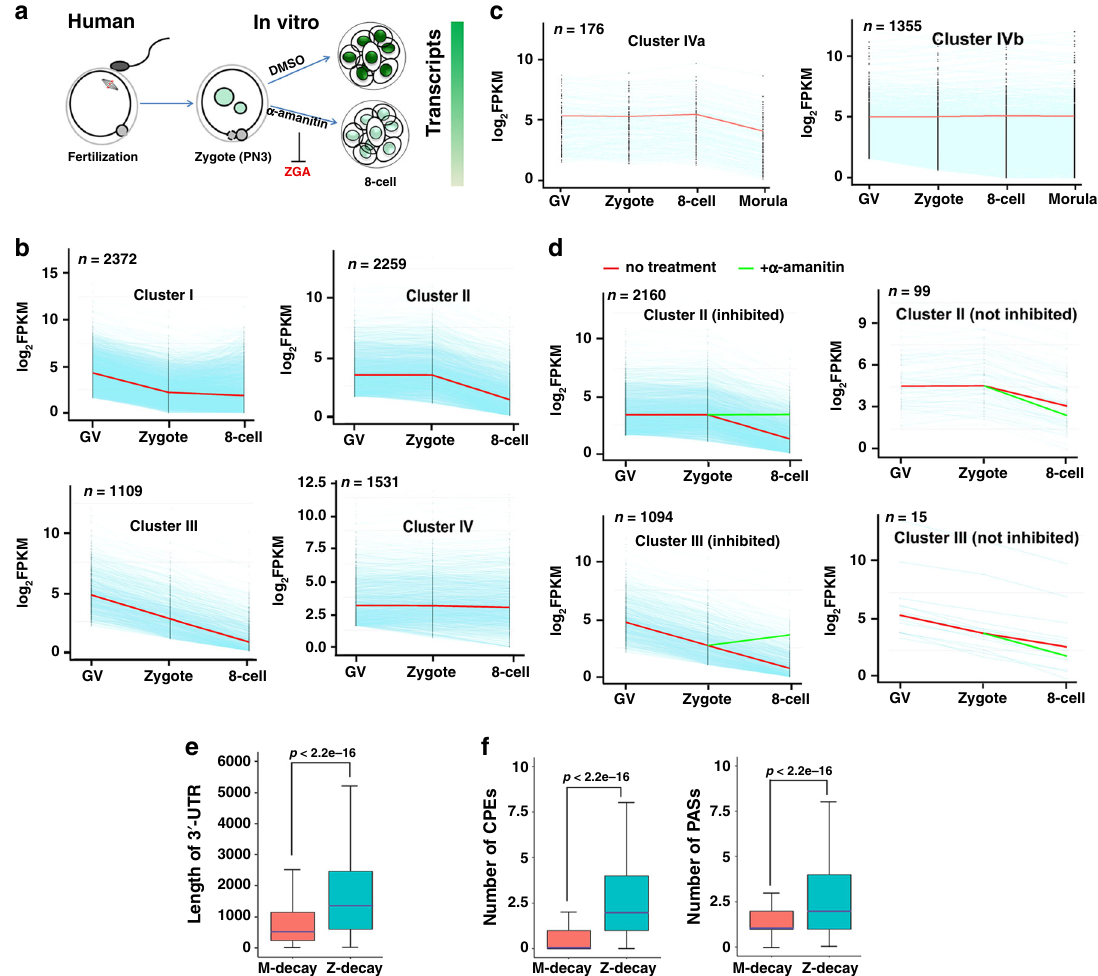
Fig. 1 Dynamics of maternal mRNA clearance in human preimplantation embryos. a This illustration shows the treatment of human oocytes and embryos for RNA-seq. Zygotes were treated with or without α -amanitin (25 ng/ μ l) and then cultured till they reached the 8-cell stage. b and c Degradation patterns of human maternal transcripts at the GV, zygote, 8-cell, and morula stages. Transcripts with FPKM > 2 at the GV stage were selected and further analyzed. Each light blue line represents the expression levels of one gene, and the middle red line represents the median expression levels of the cluster. d Degradation patterns of maternal transcripts in human embryos with or without α -amanitin treatment. Transcripts with FPKM (2-cell)/FPKM (zygote) < 0.5 were selected for analysis. Each light blue line represents the expression levels of one gene. The middle red line represents the median expression levels of the cluster. The green line represents the median expression levels of the cluster after α -amanitin treatment. e and f Average 3 ʹ -UTR length e and numbers of CPEs and PASs f in the 3 ʹ -UTR of the human M-decay and Z-decay transcripts. The box indicates the upper and lower quantiles, the purple thick line in the box indicates the median, and the whiskers represent the 2.5th and 97.5th percentiles. Data are presented as mean values± SEM. P by a two-tailed Student ’ s t -test. n = 2372 genes for M-decay; n = 2259 genes for